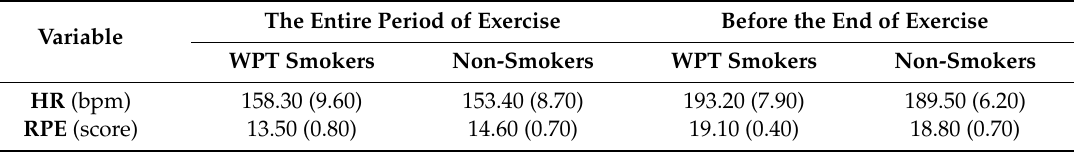
Table 3. Heart rate (HR) and rating of perceived exertion (RPE) for WPT smoker and non-smoker young women.